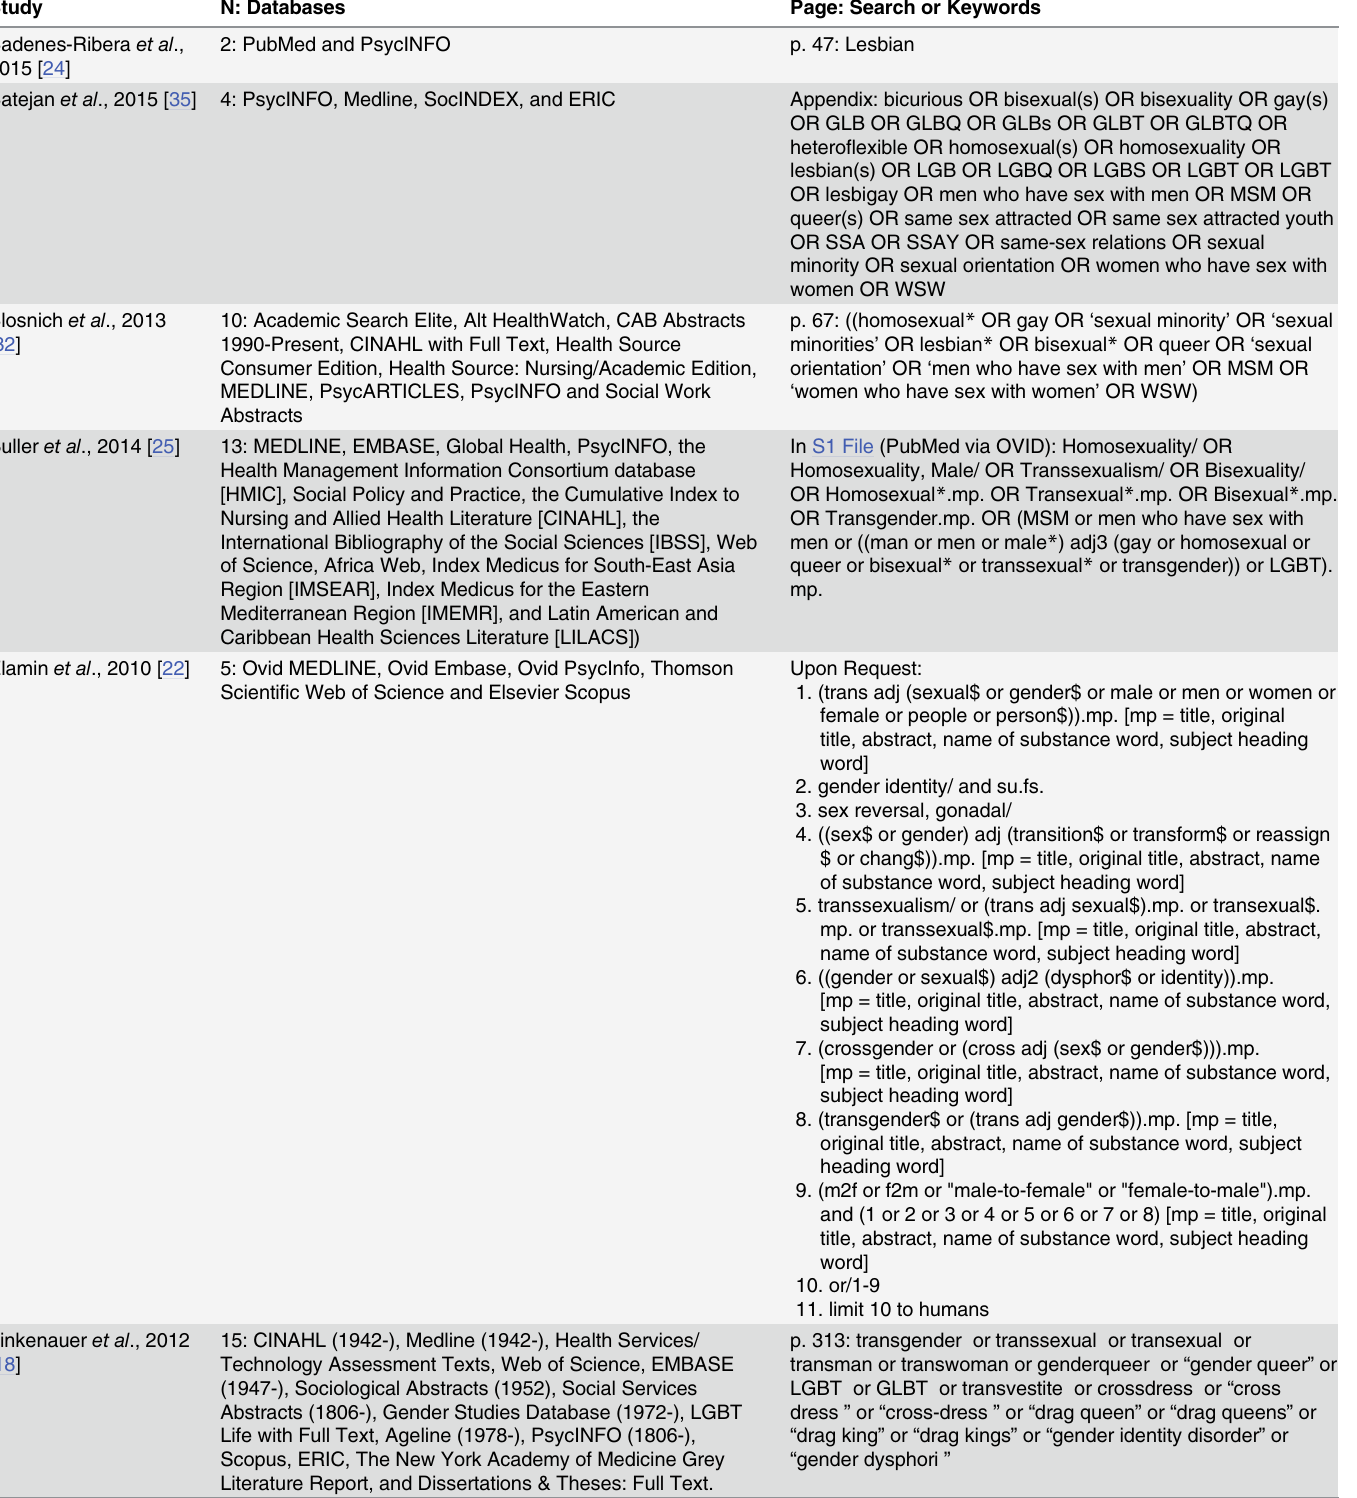
Table 1. Study databases and search keywords (or final search strategy, if reported), N = 19, May 28 – 29, 2015.